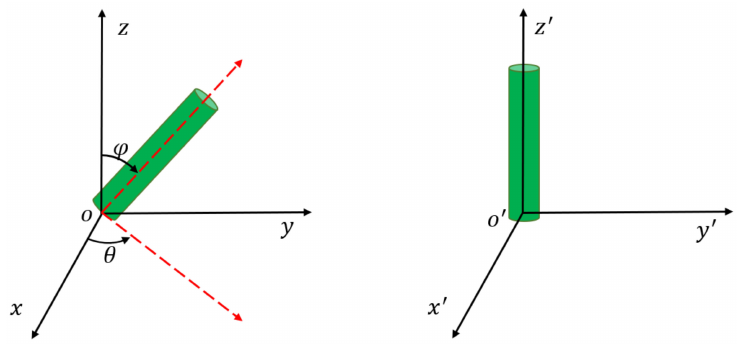
Figure 2. Angle parameter of fiber distribution in